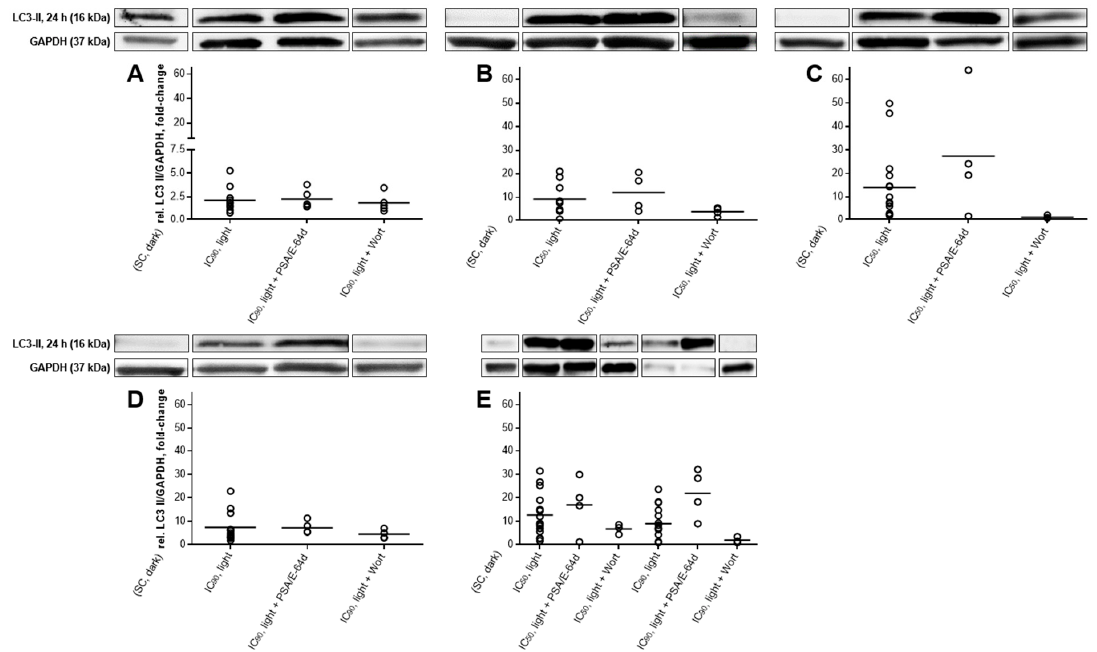
Figure 11. Formation of LC3-II in A-427 ( A ), BHY ( B ), KYSE-70 ( C ), RT-4 ( D ), and SISO ( E ) cells after photodynamic treatment in absence or presence of lysosomal protease inhibitors pepstatin A (PSA)